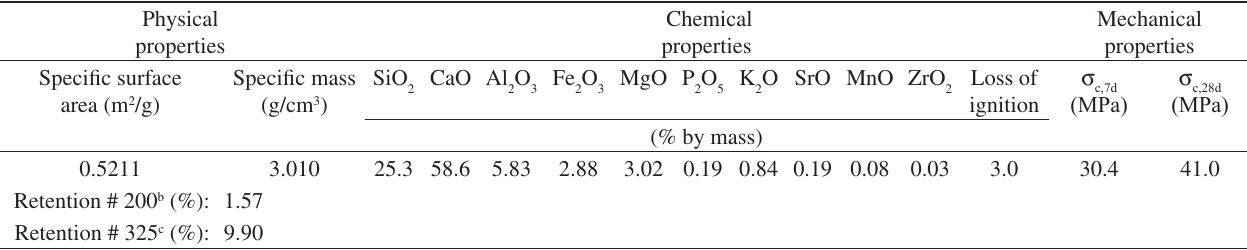
Table 1. Physical, chemical and mechanical characterization of ordinary Portland cement (CP-IIE a ).